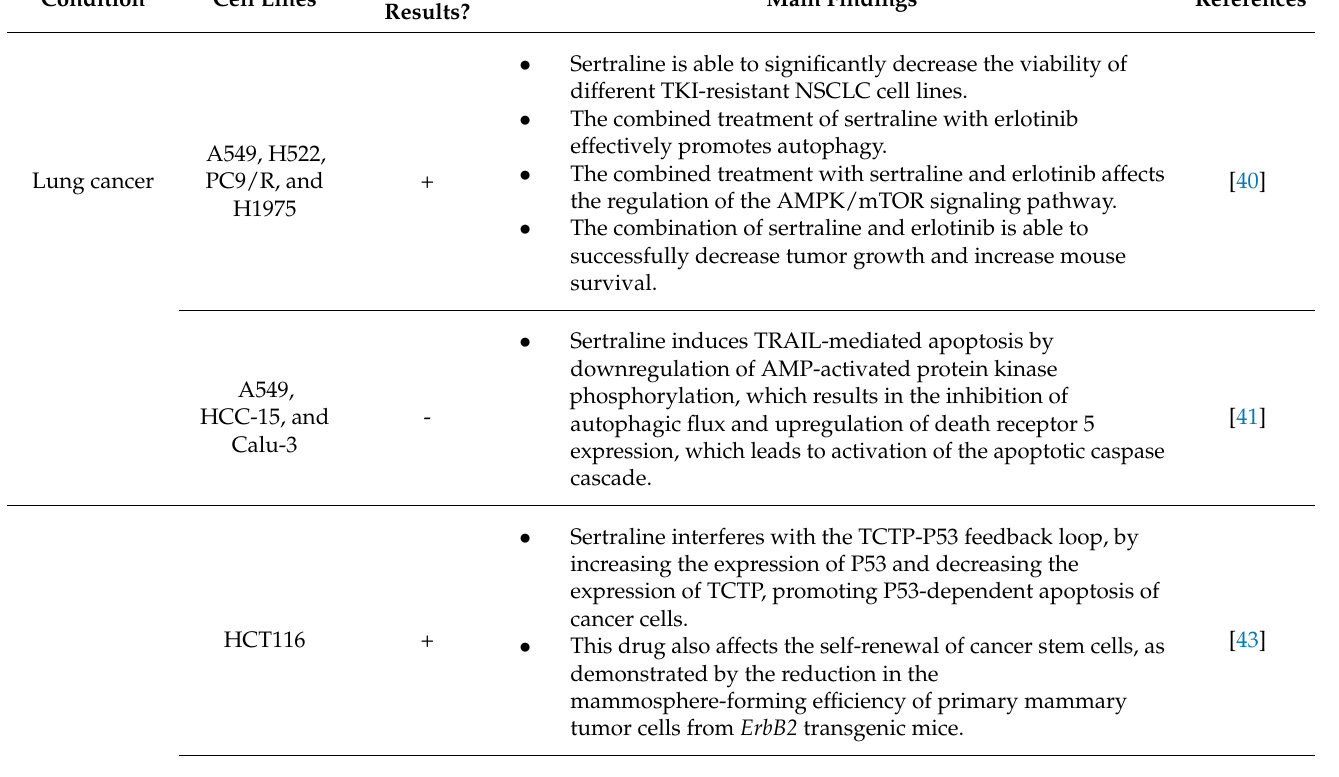
Table 1. Summary of the main findings described in this review concerning the anticancer effects of sertraline. [+] and [-] indicate existence or absence of in vivo studies, respectively.